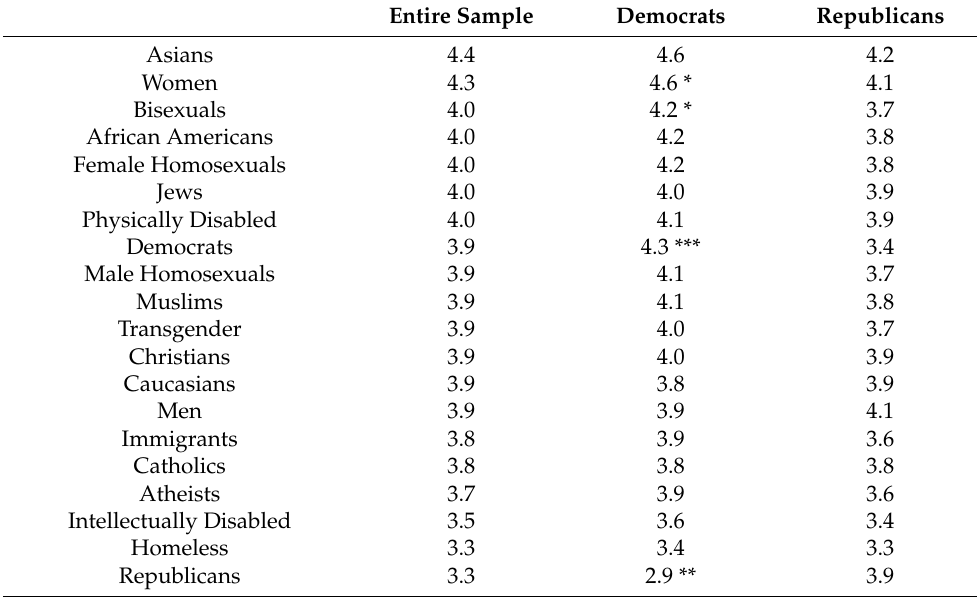
Table 5. Mean Ratings of Intelligence of 20 Social Groups by Political Affiliation.